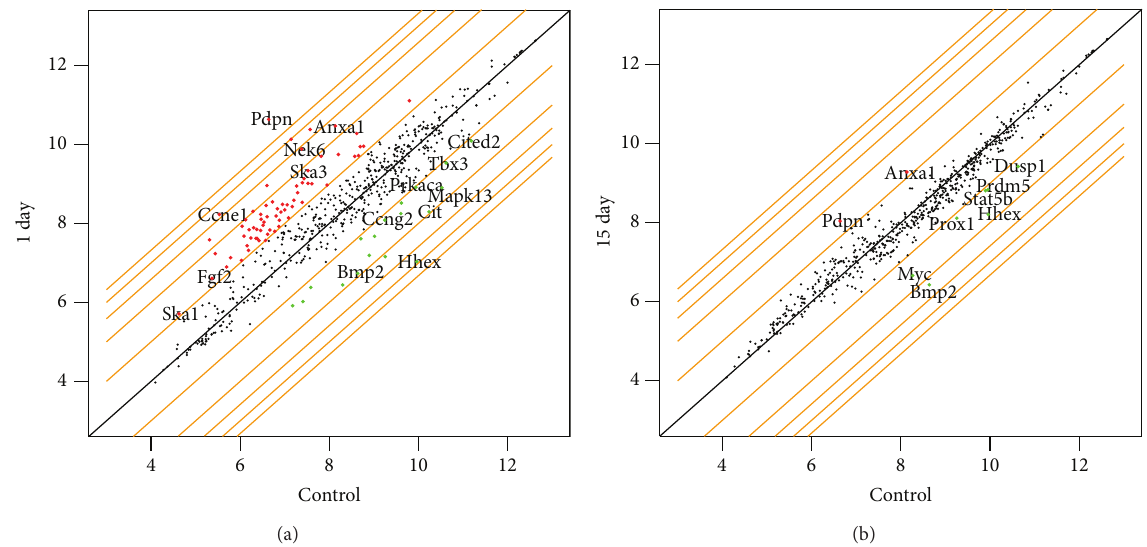
Figure 3: Affymetrix Rat Gene 1.1 ST Array. Expression (log2 signal intensity) of genes involved in cell cycle during enucleation-induced rat adrenocortical regeneration. Scatter plot graphs show data for days 1 and 15 of adrenal regeneration, in relation to control glands. Broken grey lines mark statistically significant changes (fold > 2, 𝑃 < 0.05 ). Dots outside the parallel lines represent transcripts with greater than 2-fold up-/downregulation of expression; upper left part of the graph—increase of expression, lower right part—decrease of expression. At day 1 after enucleation 67 genes were found to be upregulated, for example, Anxa1, Nek6, cyclin E1, and Fgf2, while at day 15 only 2 (Anxa1, Pdpn). At day 1 of regeneration expression of 18 genes decreased (cyclin G2, Mapk13, protein kinase alpha (Prkaca), Bmp2). At day 15 of experiment only 7 genes were downregulated—Bmp2, Prox1, Hhex,